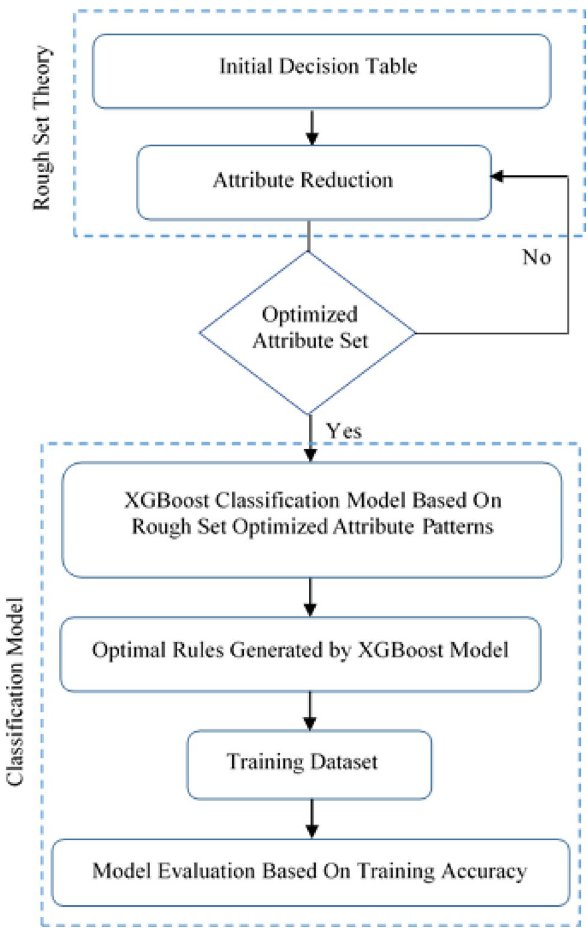
Figure 4. Fusion of rough set theory and XGBoost for landslide prediction